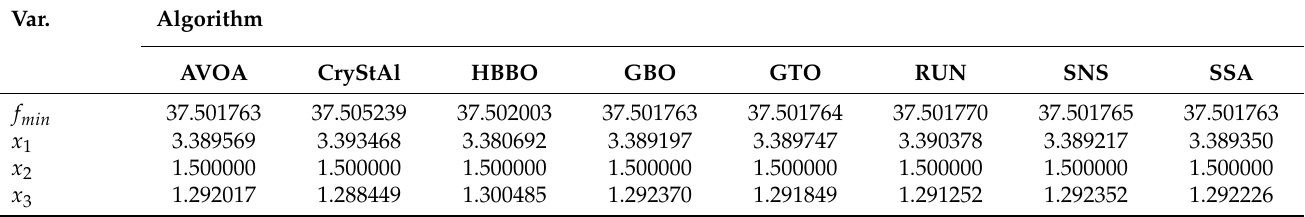
Figure 4. Best run convergence curves of each meta-heuristic algorithms (out of 100 repetitions) in the crane hook design optimisation problem. Table 5. Best optimum solution of each algorithm for the crane hook design optimisation problem.